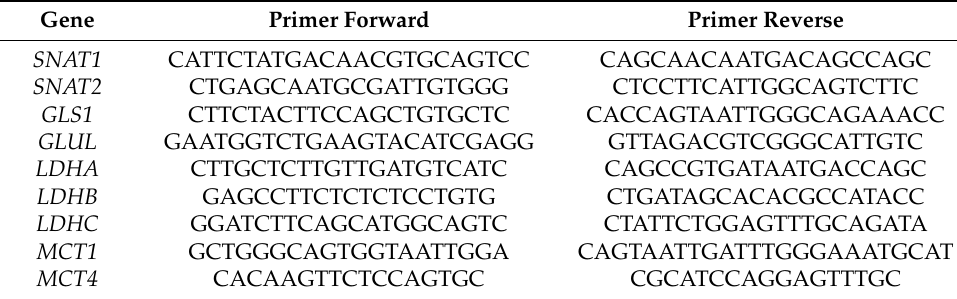
Table 2. Primer sequences used for